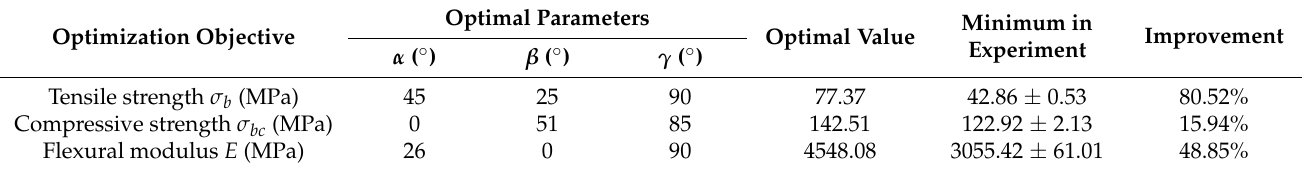
Table 6. The optimal parameters for single mechanical